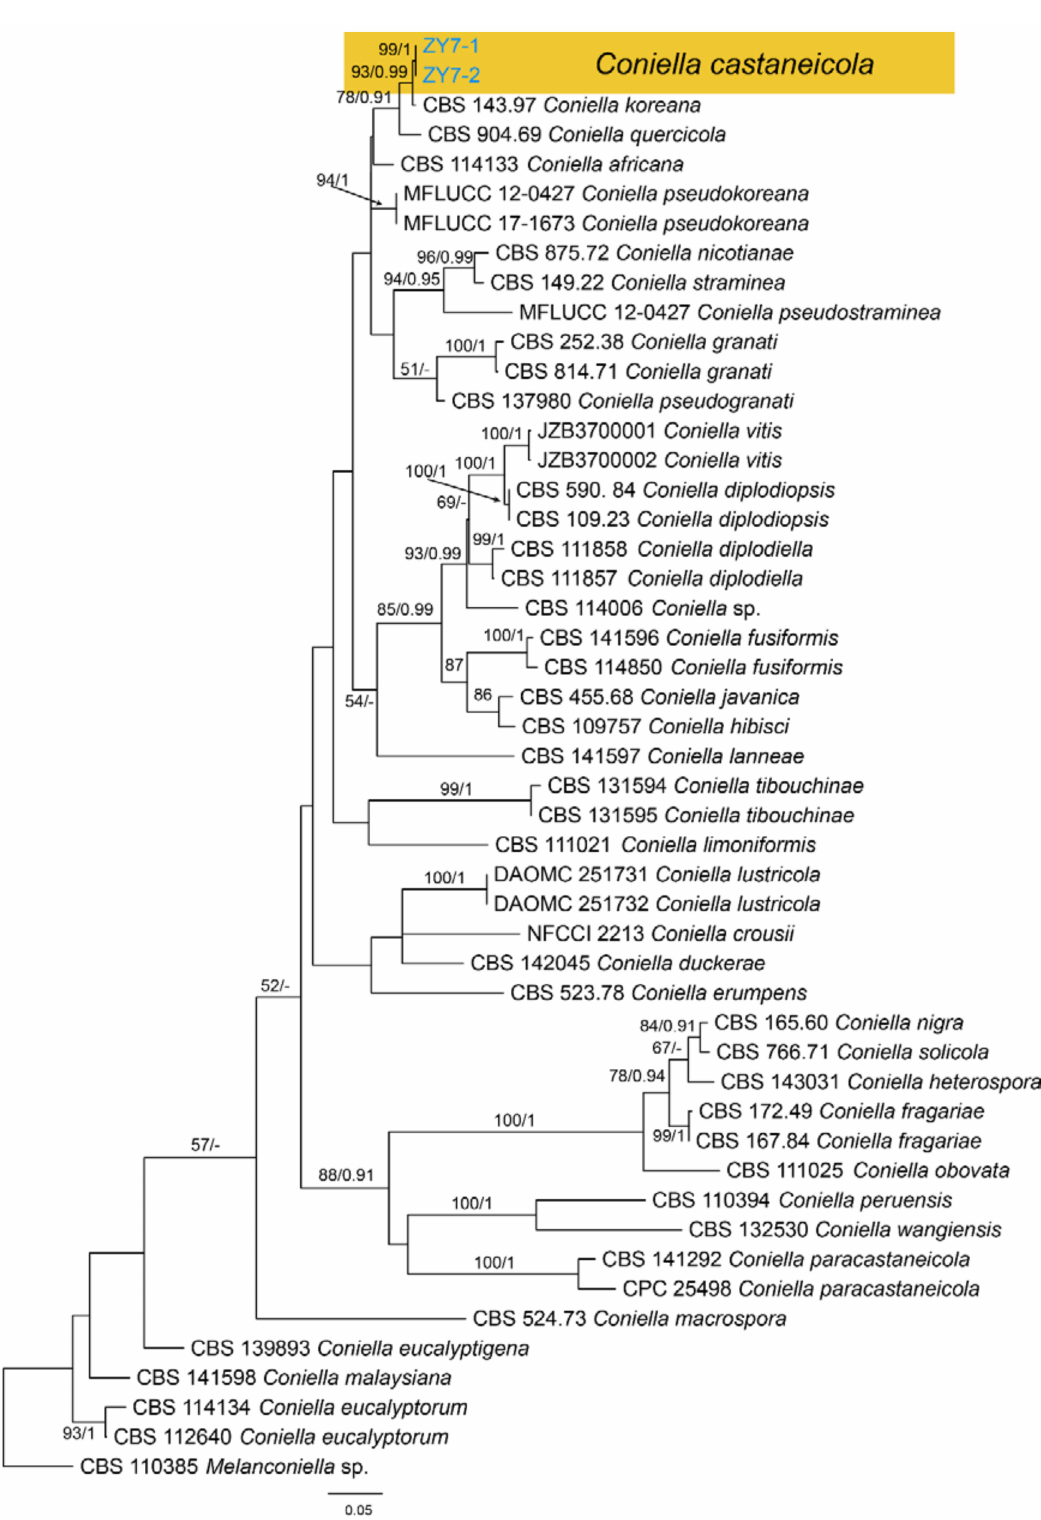
Figure A11. Phylogram generated from RAxML analysis based on combined ITS, tef1 and tub2 sequence data of Coniella isolates. The tree was rooted to Melanconiella sp. (CBS 110385). The scale bar indicates 0.05 nucleotide changes per site. Isolates from this study are marked in blue, and the identified species is marked in